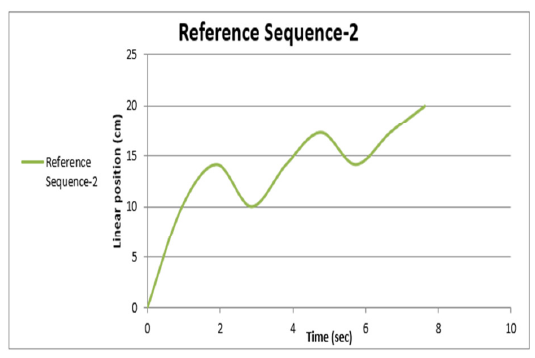
Fig. 15. Reference sequence for the second obstacle.